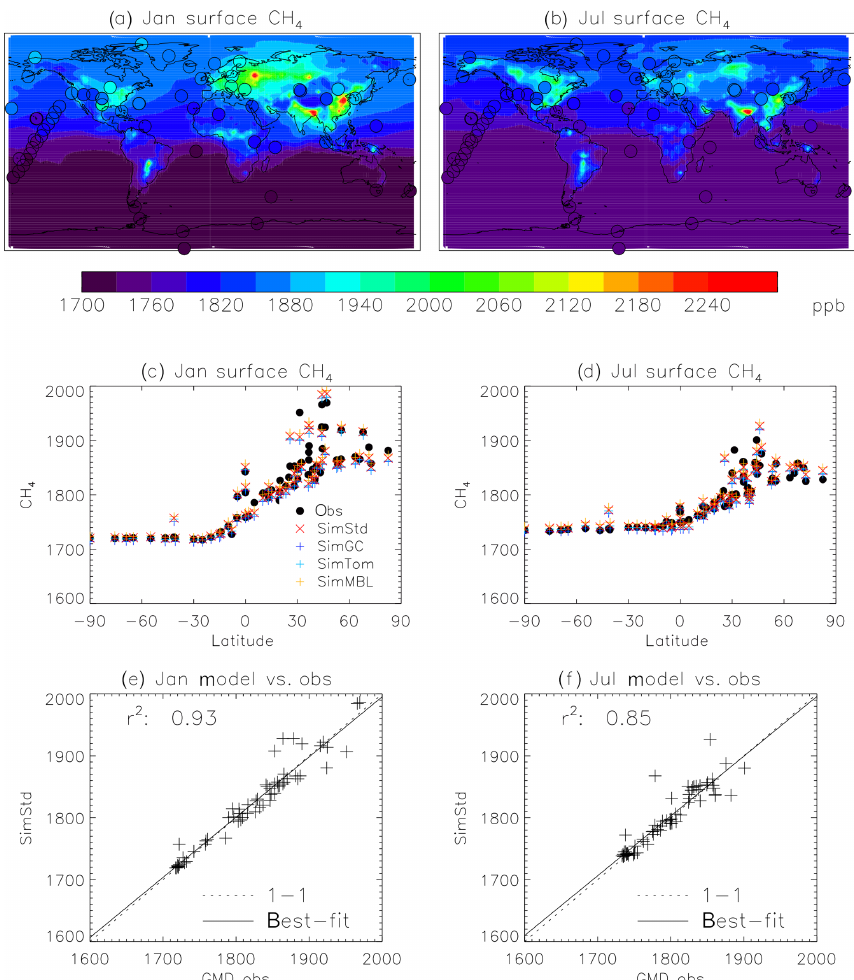
Figure 4. Comparison of 2004 simulated and observed surface CH 4 concentrations for January (a, c, e) and July (b, d, f) . (a, b) Surface concentrations of CH 4 from SimStd are overplotted with the concentrations from the GMD observations in circles. (c, d) GMD observations (black circles), SimStd (red × ), SimGC (dark blue + ), SimTom (light blue + ), and SimMBL (orange + ) CH 4 as a function of latitude. (e, f) SimStd CH 4 (ppb) at the observation locations versus the GMD observations ( + signs) as well as the regression line (solid) and one-to-one line